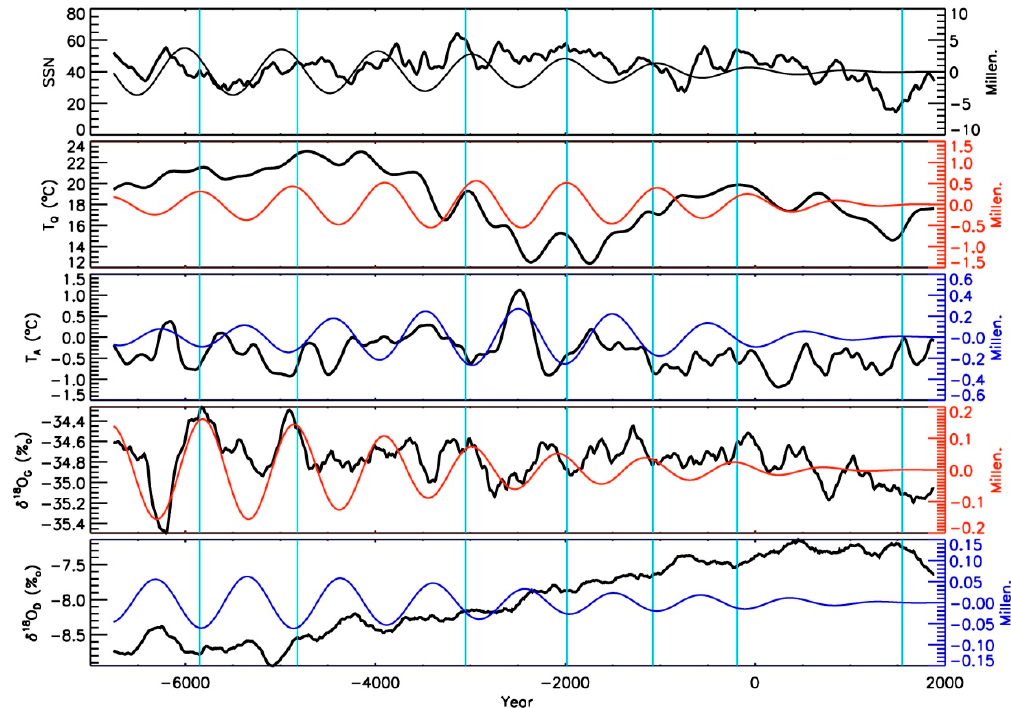
Figure 4. Comparison between SSN and climate indices using their 200-year running averages (thick lines) and their 1000-year cycle components (thin lines). Table 1. Linear Pearson correlation coefficients (CC) between SSN and climate indices for their millennial-cycle variations